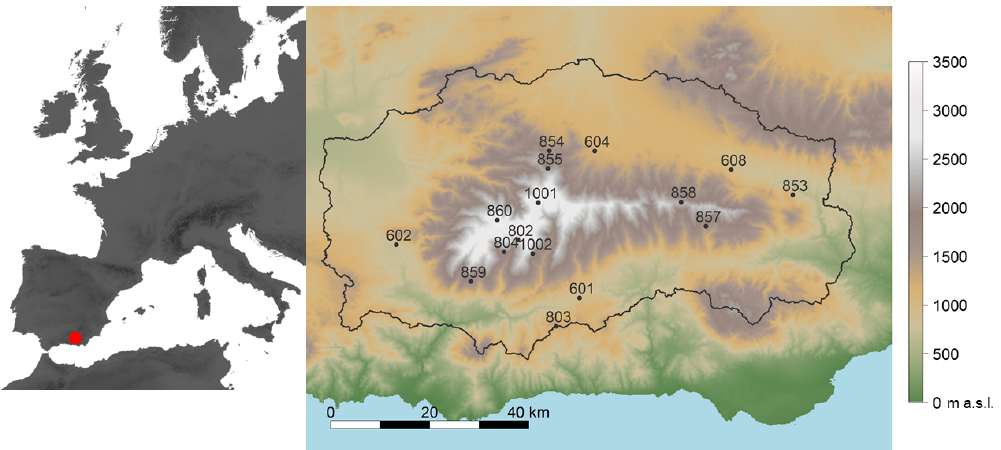
Figure 1. Location of the study site in southern Spain (left). Digital elevation model (DEM) and weather stations in Sierra Nevada (SN) (right). The numbers correspond to the station codes. Table 1. Information of the weather stations included in this study: elevation, z (ma.s.l.); code; data length, as initial and final dates of the time series; number of initially available daily records, N o (days); number of available daily records after the quality check, N (days); rate of days for cloudy, N CI < 0 . 3 (%), partially cloudy, N 0 . 3 < CI < 0 . 6 (%), and clear-sky conditions, N CI > 0 . 6 (%); and maximum, R